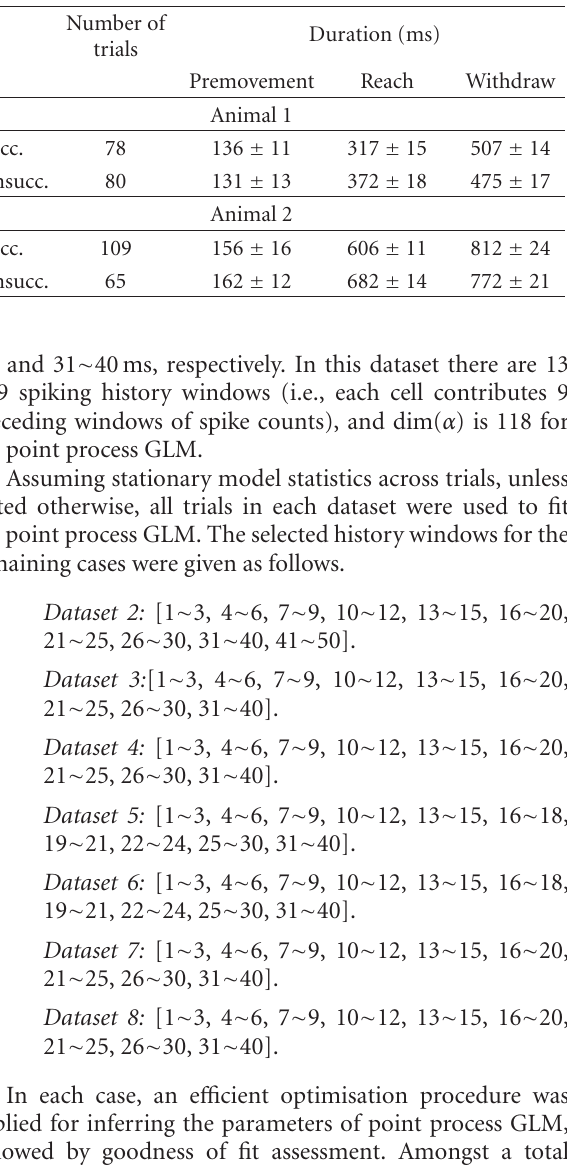
Table 2: Mean duration ± SE (ms) at each stage of task performance across trials for two animals during successful and unsuccessful